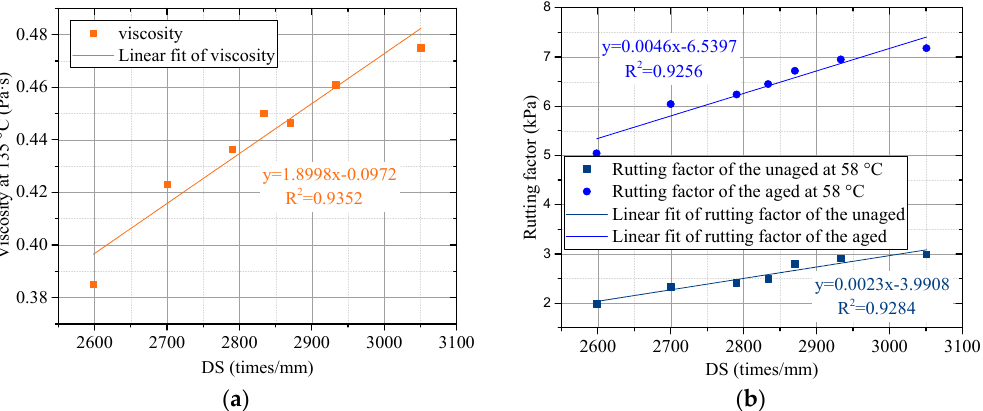
Figure 10. The linear fit of DS, viscosity, rutting factor. ( a ) DS with viscosity; ( b ) DS with rutting factor.